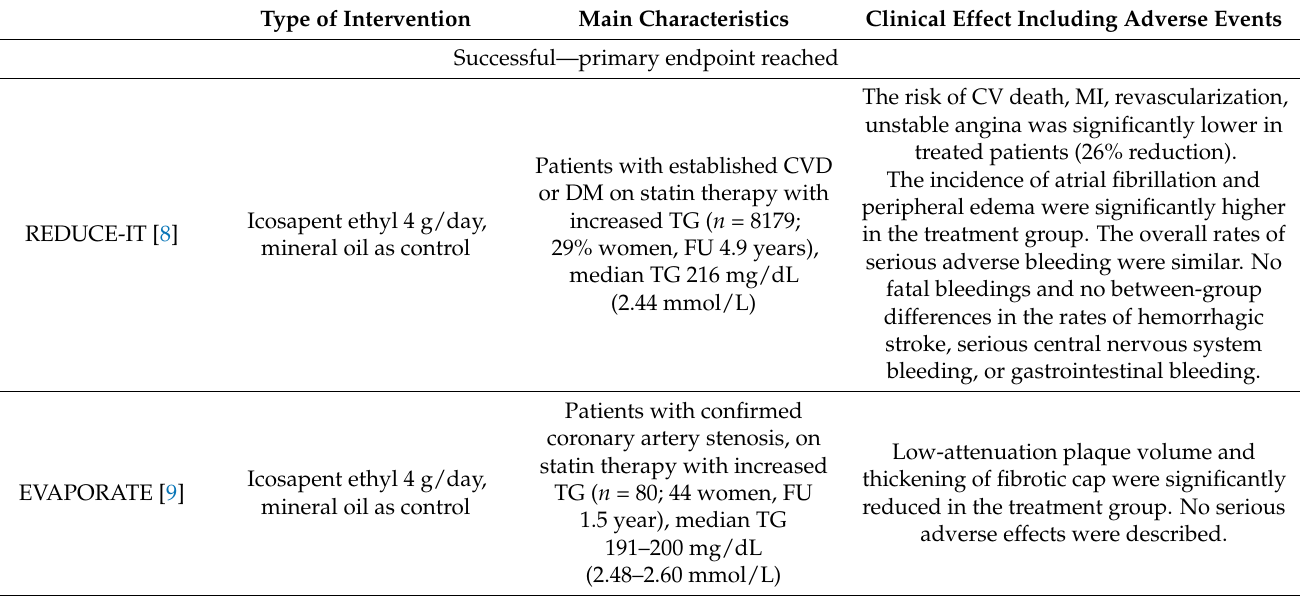
Table 1. Main clinical trials focused on the effect of n-3 PUFAs on cardiovascular events (created partly on information and data from